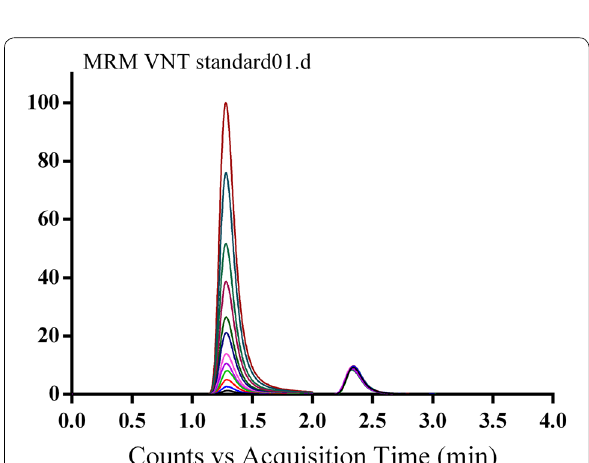
Fig. 3 Overlayed TIC chromatograms of MRM of VNT (5–500 ng/mL) and IS (50